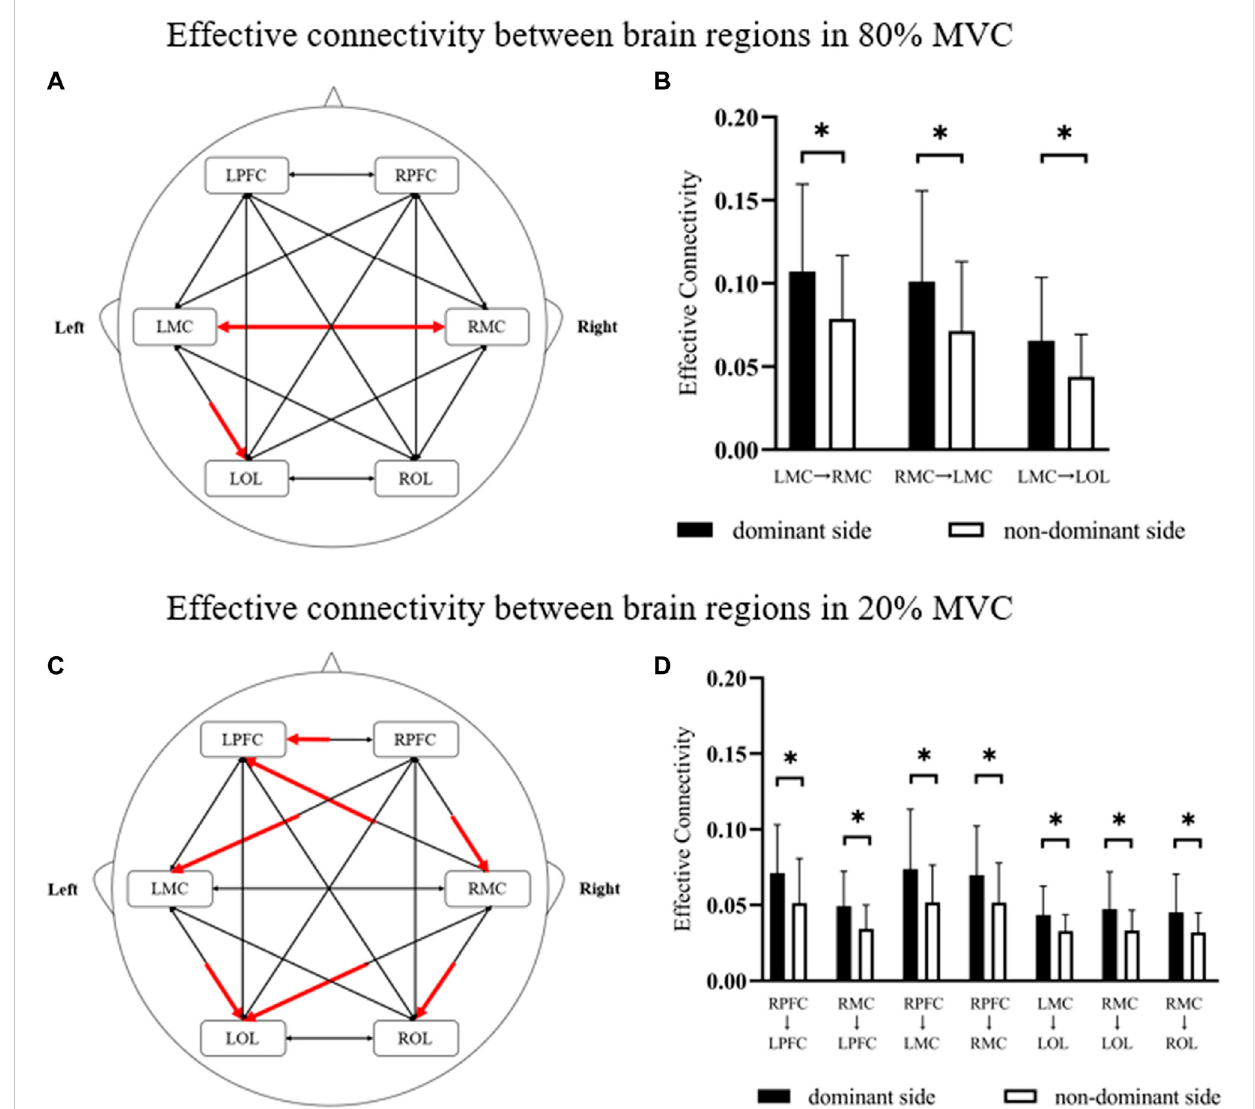
FIGURE 4 The results of signi fi cant differences in effective connectivity between brain regions in different conditions. (A,B) The change is represented by the effective connectivity of the dominant side relative to the non-dominant side under 80% MVC. (C,D) The change is represented by the effective connectivity of the dominant side relative to the non-dominant side under 20% MVC. The red line indicates a signi fi cant increase statistically ( p < 0.05), where * indicates p <